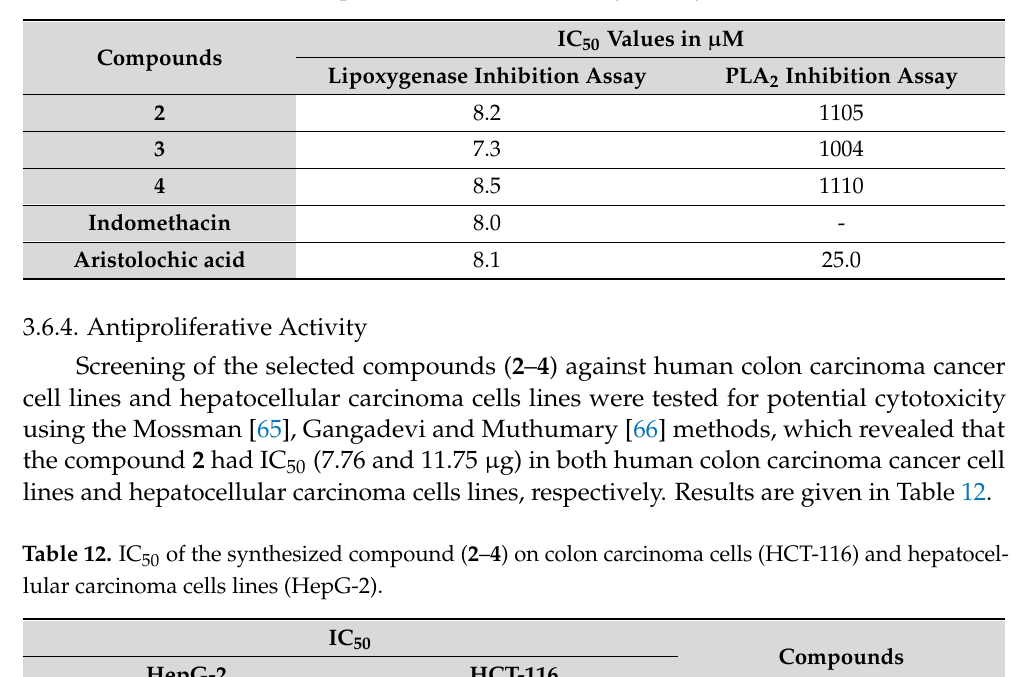
Table 11. IC 50 values of the compound for anti-inflammatory activity.